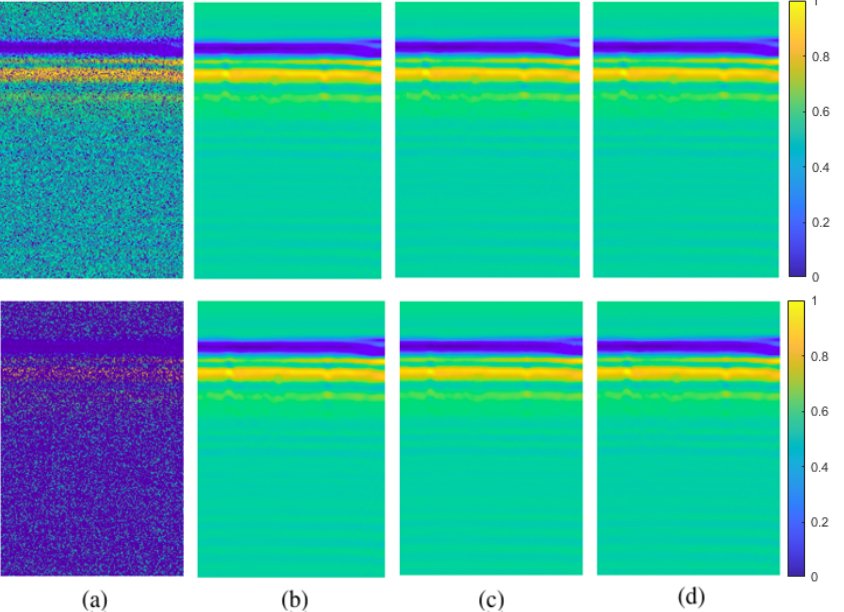
Figure 16. First row 30% and second row 80% pixel-wise missing data case for real data-I: ( a ) GPR image with missing entries, ( b ) original GPR image, recovered images by ( c ) NNM, ( d ) DIP.